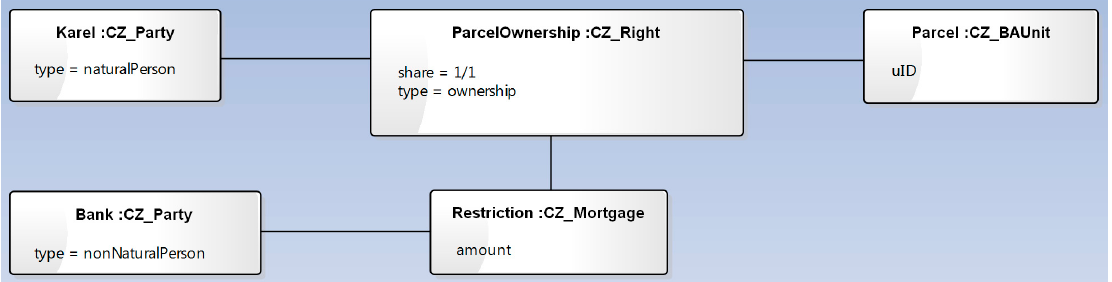
Figure 5. An example of a mortgage.